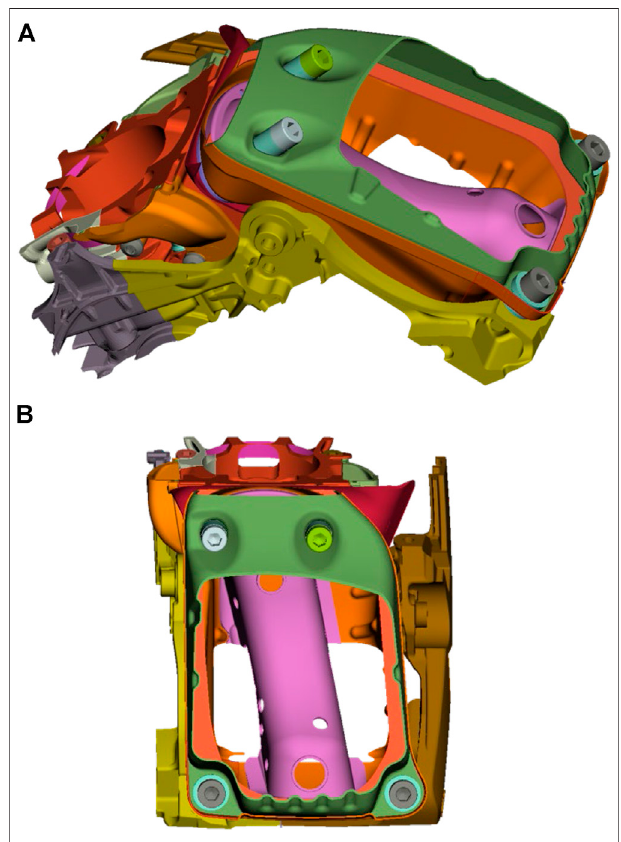
FIGURE 1 | Assembly of the carburetor with (A) iso view and (B) top view.